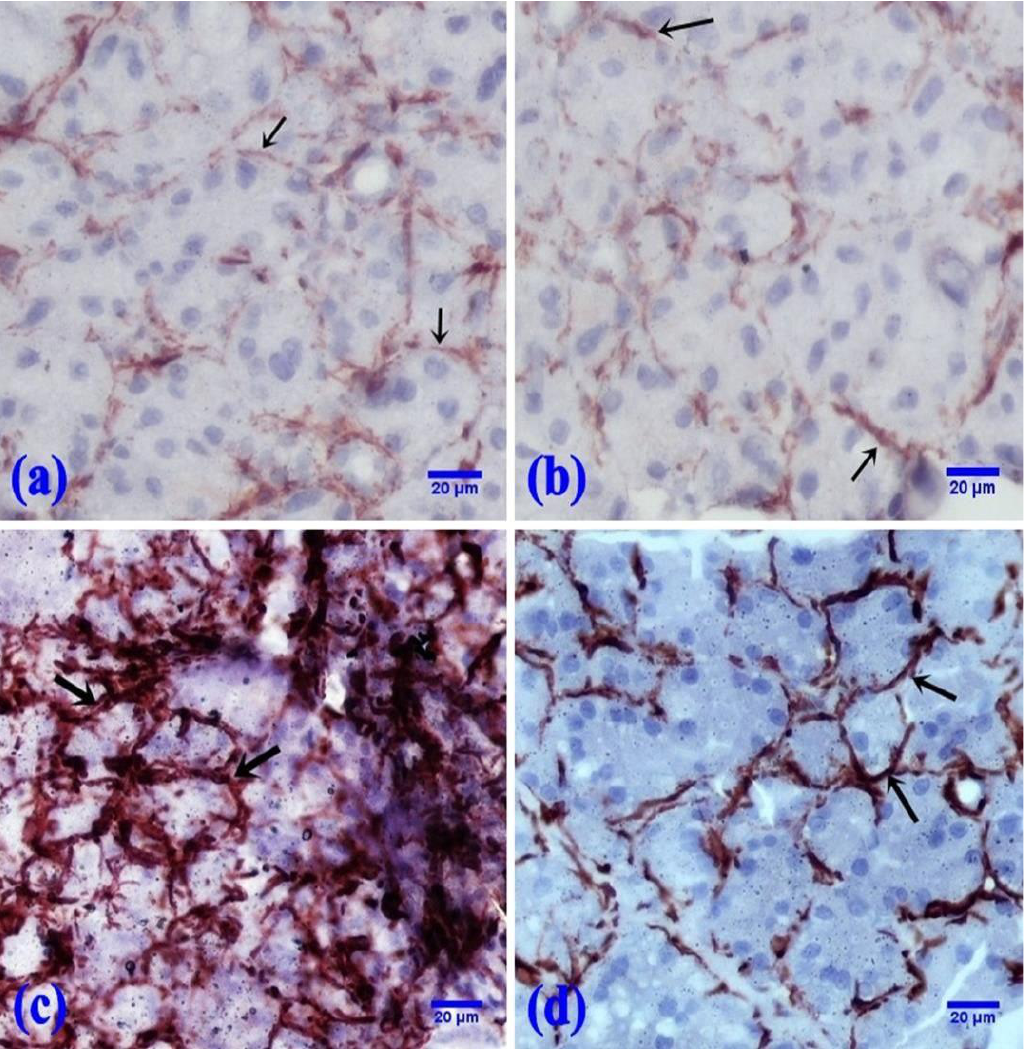
Figure 4. Photomicrographs of the α -SMA immunoreaction at the periphery of the acini ( ↑ ). ( a , b ) The control and FEB groups, respectively, showed a faint immunoreaction. ( c ) The 5-FU group showed a marked immunoreaction. ( d ) The FEB + 5-FU group showed a moderate immunoreaction. ( α -SMA immunostaining, × 400; 8 rats/group). Table 4. Changes in area% of α -smooth muscle